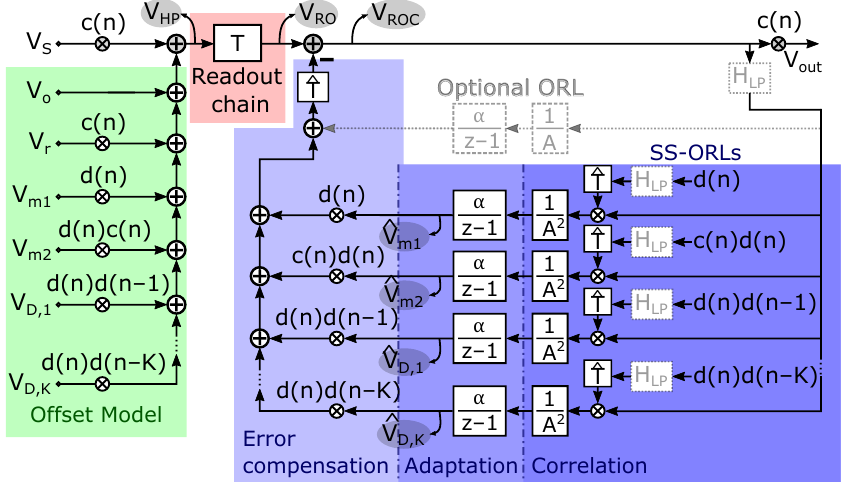
Figure 7. System-level overview of the proposed offset-suppression solution, with various spread- spectrum ORLs to remove the randomized Hall plate